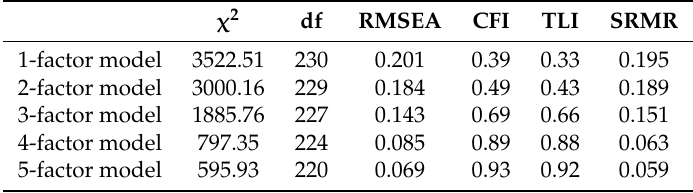
Table 1. Results of confirmatory factor analysis.